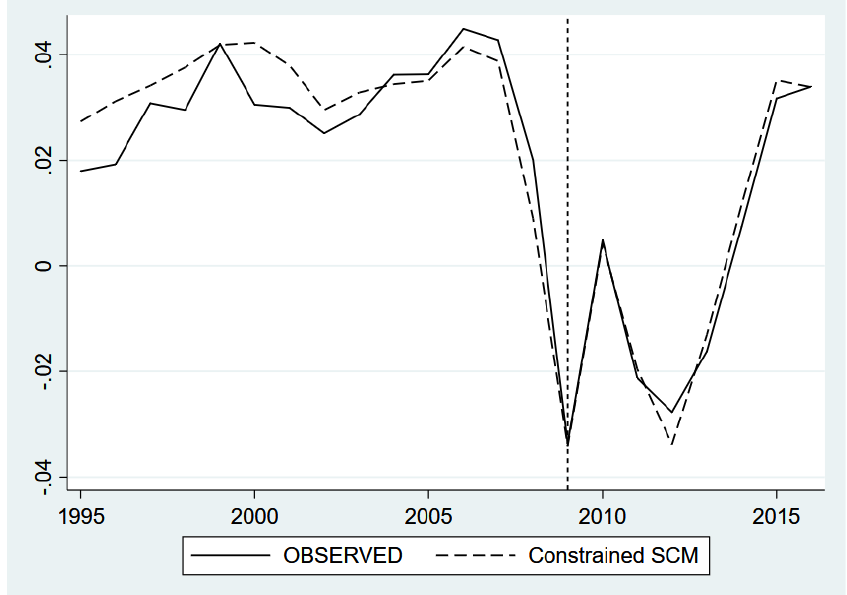
Figure 8 : Observed and constrained SCM GDP growth rates over the period 1995 −